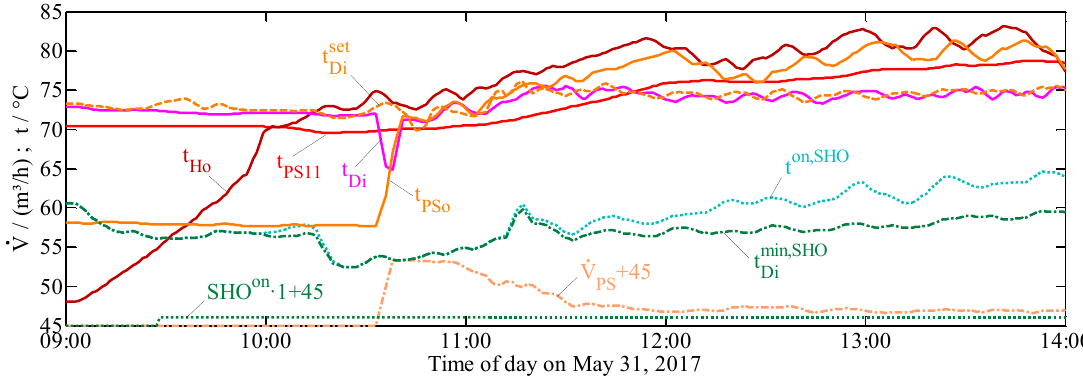
Figure 3. Start-up period of solar heat operation (SHO) without the improved control strategy.